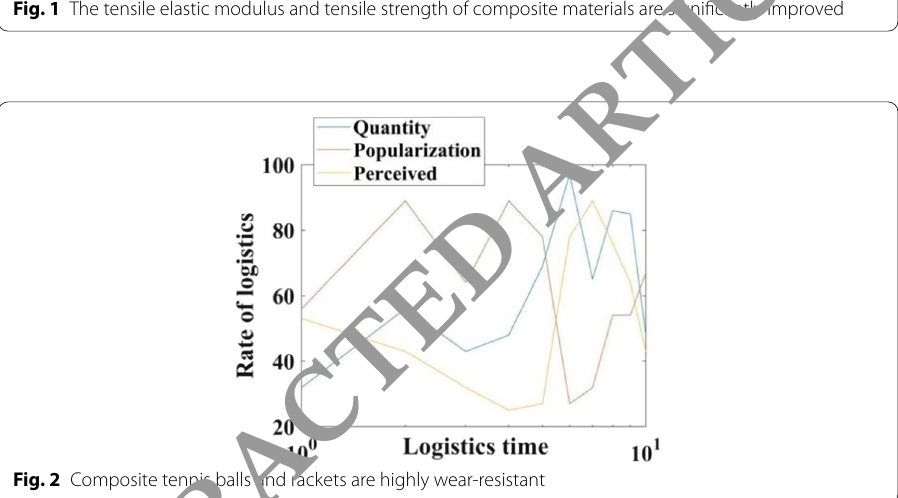
Fig. 2 Composite tennis balls and rackets are highly